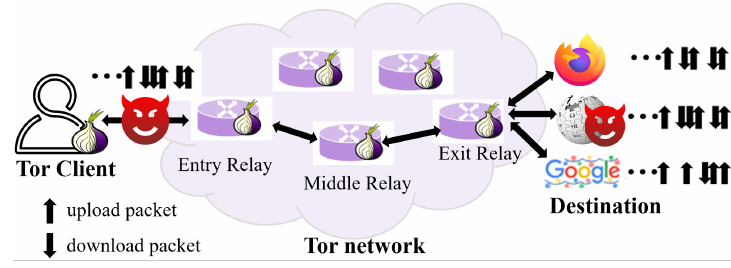
Figure 1. Threat